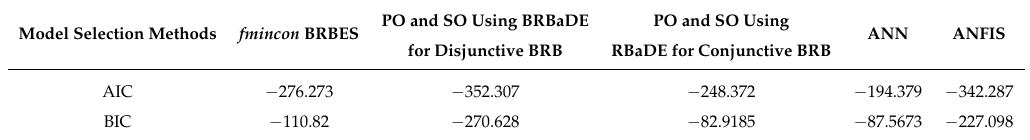
Table 9. Model-complexity analysis for fmincon , Disjunctive BRB, Conjunctive BRB, ANFIS, and ANN.